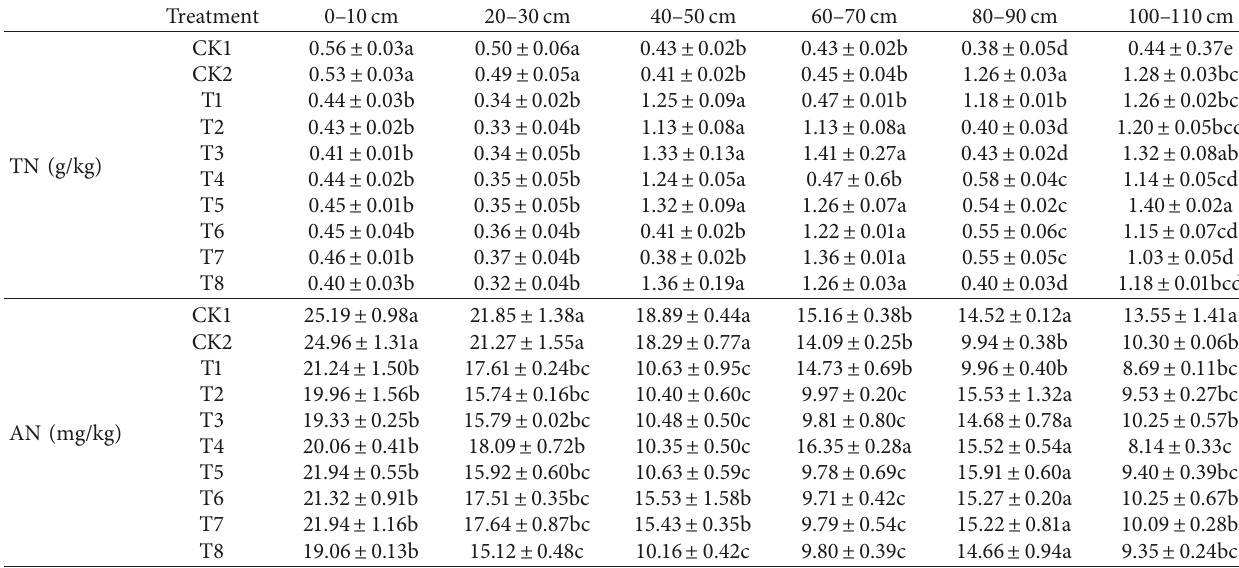
Table 4: Total and available nitrogen of interlayered soil